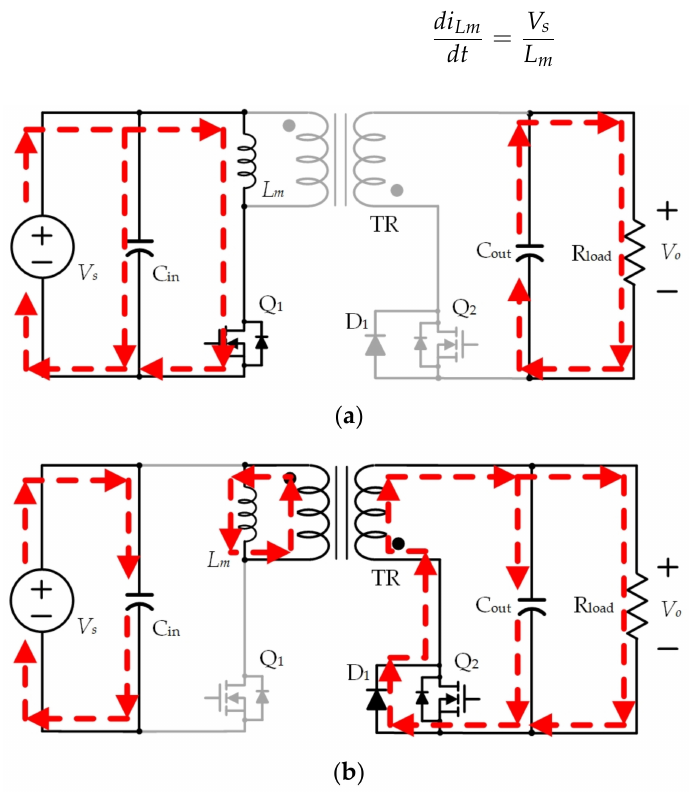
Figure 3. Operation modes of the DSBFC: ( a ) Mode 1 (Q 1 turn on), ( b ) Mode 2 (Q 1 turn off). Mode 2 (Q 1 turn